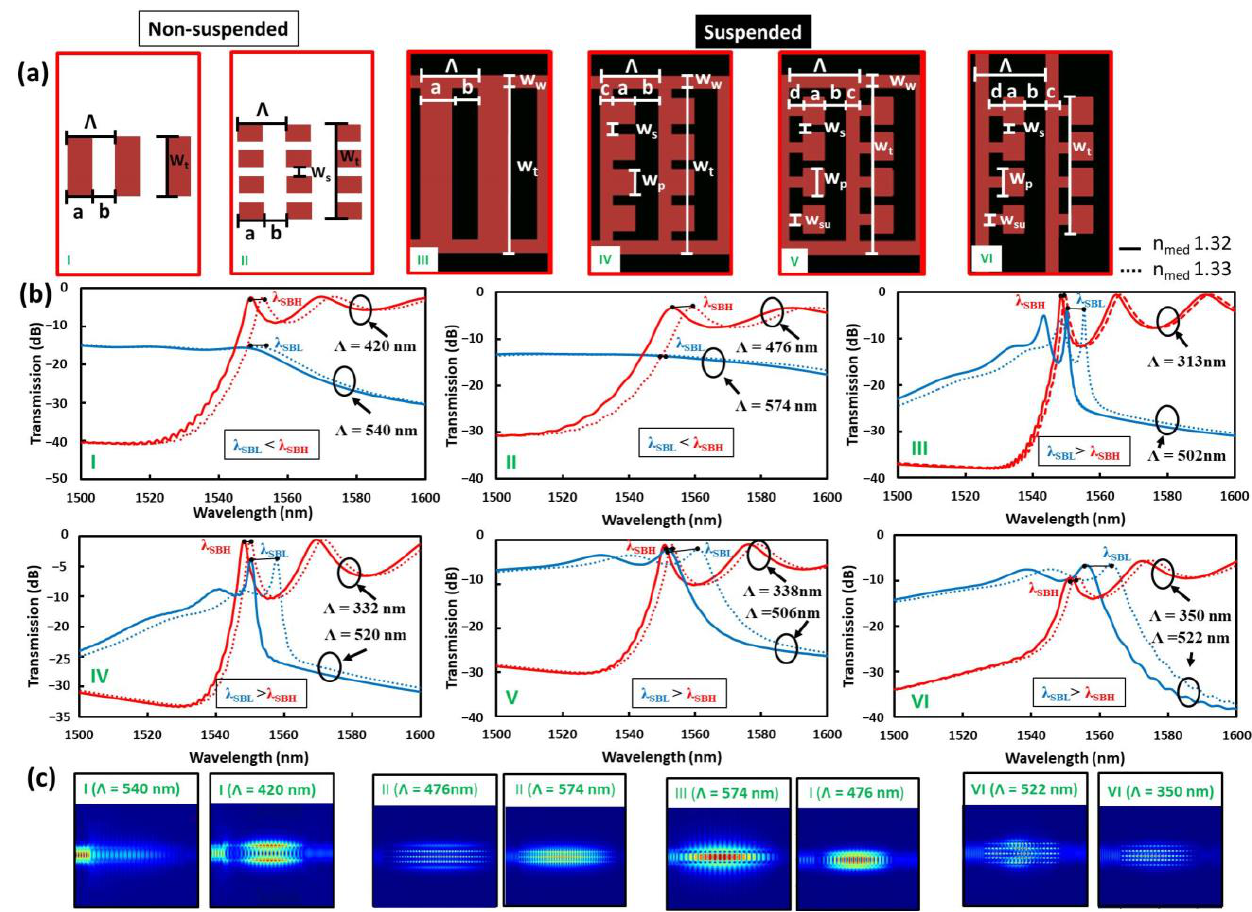
Figure 4. ( a ) Top views of the various BG RI sensors: I — SW BG, II — MS-SW BG, III- suspended ladder BG, IV – SAW BG, V — CSAW BG, and VI — CWIRE BG. ( b ) The respective transmission spectra with shorter (in blue) and longer (in red) wavelength-sides of the stopband at a fixed wavelength of 1550 nm fitted by Λ values. Parameters used are as follows: H = 220 nm (I, III– VI), 500 nm (II); W t = 500 nm (I), 980 nm (II, VI), 600 nm (III), 1300 nm (III – V); W s = 60 nm (II, IV-VI); W su = 60 nm (II, V, VI); W w = 100 nm (III – V); d = 100 nm (IV – VI); c=100nm (V, VI); the duty ratios for all of the cases is 0.5. ( c ) E-field top views for the various